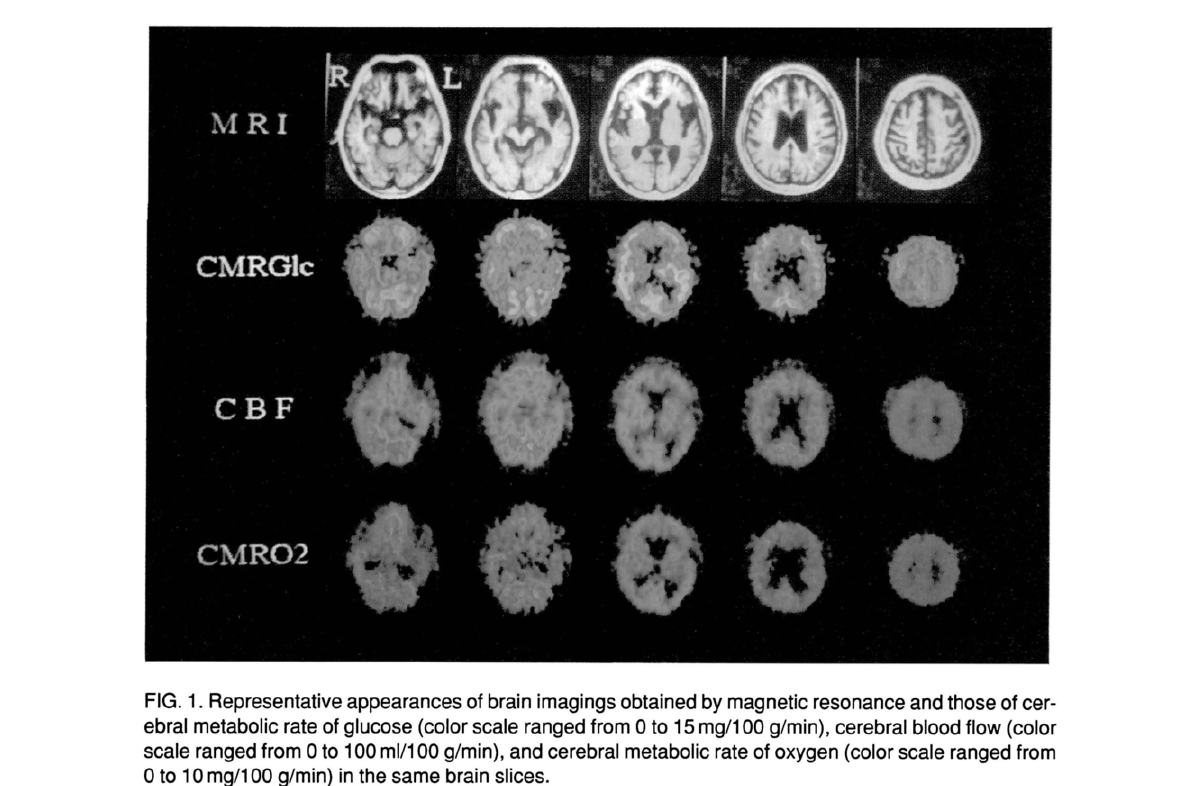
FIG. 1. Representative appearances of brain imagings obtained by magnetic resonance and those of cer ebral metabolic rate of glucose (color scale ranged from 0 to 15 mg/1 00 g/min), cerebral blood flow (color scale ranged from 0 to 100 ml/1 00 g/min). and cerebral metabolic rate of oxygen (color scale ranged from o to 10 mg/1 00 g/min) in the same brain